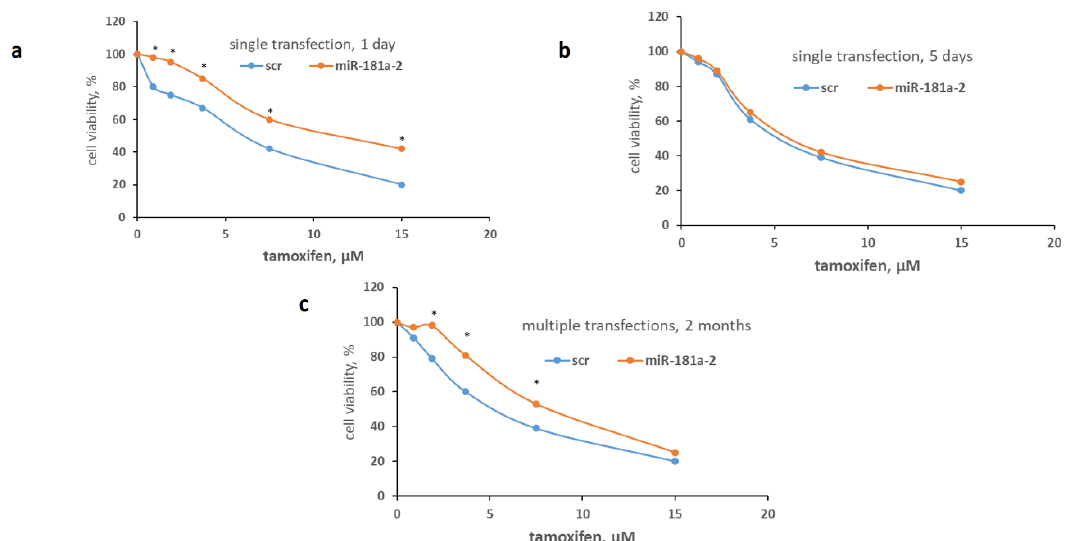
Figure 2. Influence of the miR-181a-2 on the cell sensitivity to tamoxifen. The single ( a , b ) or multiple ( c ) transfection of MCF7 cells with miR-181a-2 mimetic or scrambled RNA construct as control was performed as described in Methods. To determine the cell sensitivity to tamoxifen the cells in one day ( a ), five days ( b ) after single transfection or the cells cultured for two months after multiple transfections ( c ) were treated with tamoxifen for 72 h and the number of the viable cells was counted by the MTT test. Data represent the mean value of three independent experiments. * p < 0.05 versus scrambled (scr).